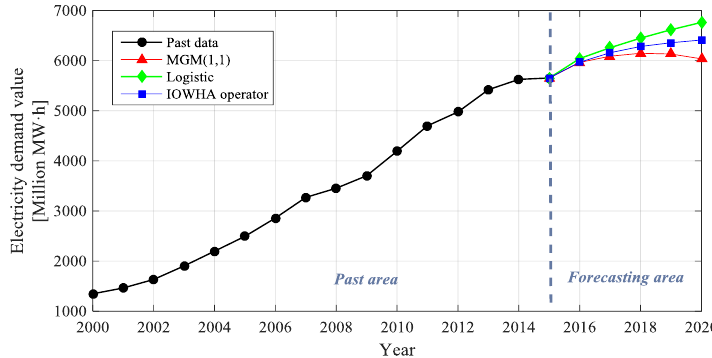
Figure 6. China’s electricity demand forecasting results analysis in 2016–2020.